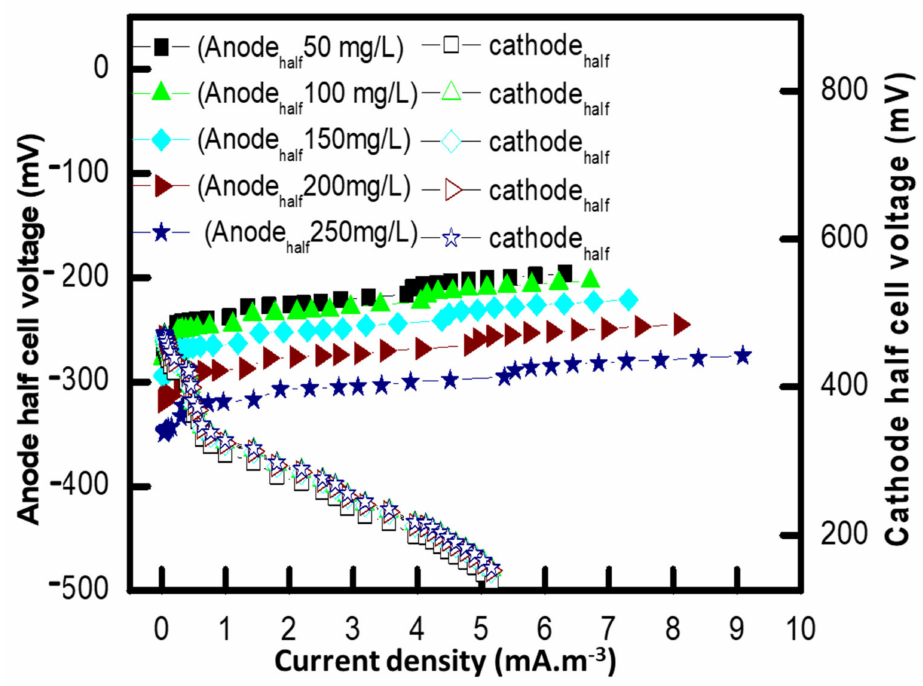
Figure 4. Analysis of anode and cathode half-cell with respect to volumetric current density. The anode and cathode half voltage data points are presented as solid and open symbols,